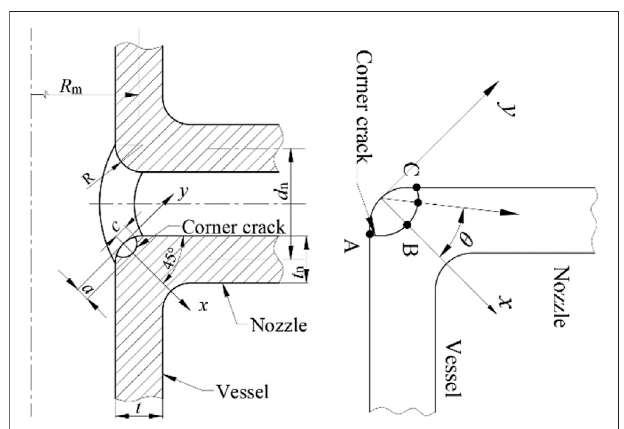
FIGURE 1 | Geometry of the nozzle corner with surface